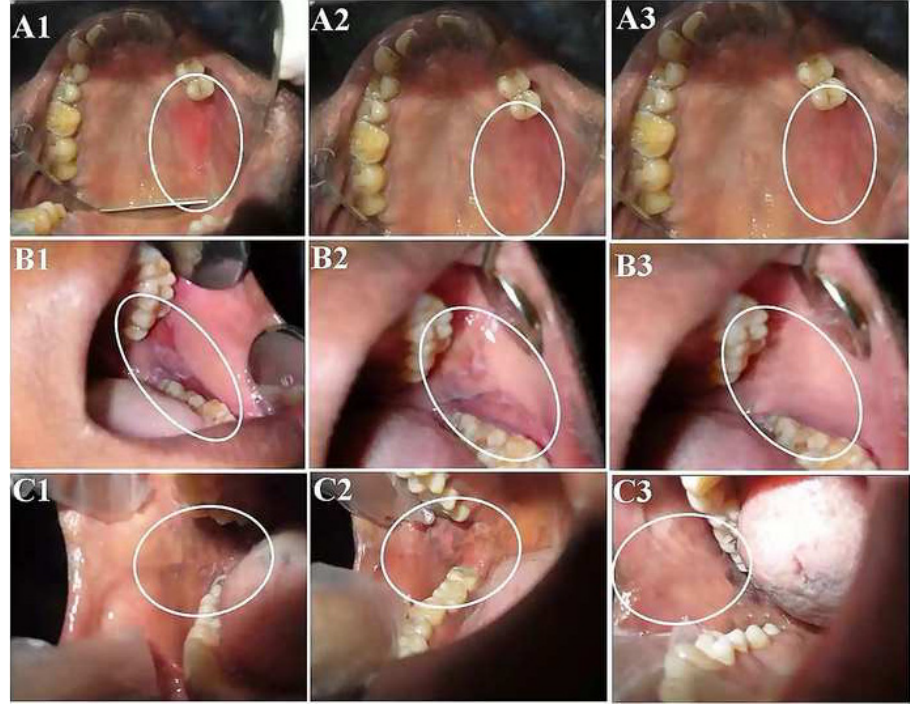
Fig. 3. Clinical photographs of OLP lesion (A1, B1, C1) before the treatment, (A2, B2, C2) and one week after the treatment and (A3, B3, C3) during follow-up, respectively.